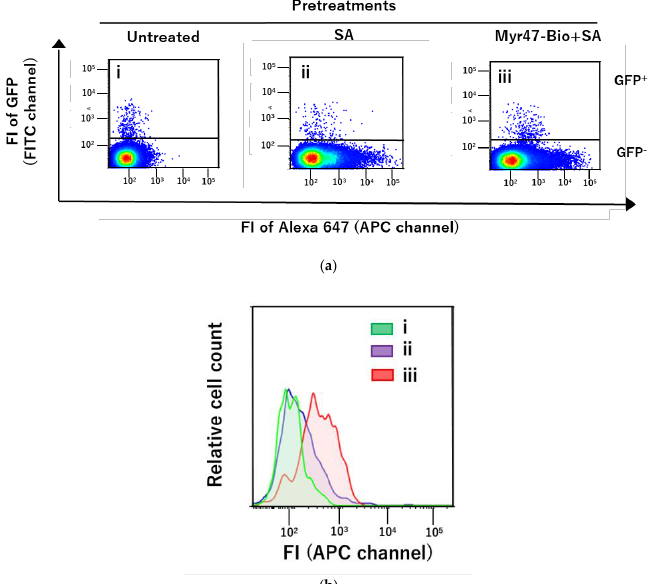
Figure 5. Flow cytometric analyses of liposomal binding to the surface of HepG2 cells transiently expressing NTCP-GFP via Myr47+SA. ( a ) Two-parameter dot plot analyses of liposomal binding to HepG2 cells expressing NTCP-GFP. The binding of DiD-DOPC/PEG-Bio (10%) to cells untreated (i), treated with SA (ii), or Myr47-Bio+SA (iii) was examined using flow cytometry. To obtain dot plot data, we analyzed 200,000 cells. As the GFP + subset in HepG2 cells expressing NTCP-GFP was considerably fewer than that in HEK293T cells, dot plots were expressed using the large dot. ( b ) Histograms of GFP + subsets, which bound DiD-DOPC/PEG-Bio (10%), in HepG2 cells expressing NTCP-GFP. Histograms (i~iii) indicated in the Figure correspond to GFP + subsets of the dot plots (i~iii), respectively.